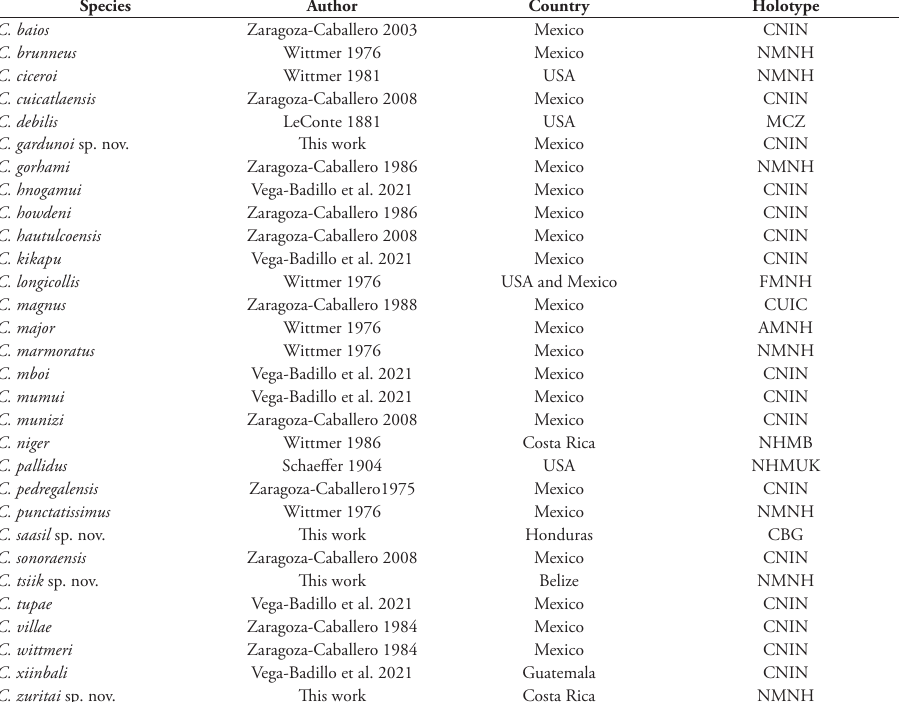
Table 1. Species of the genus Cenophengus . Country of origin of the species. Holotype: acronym of the collections where the holotype is